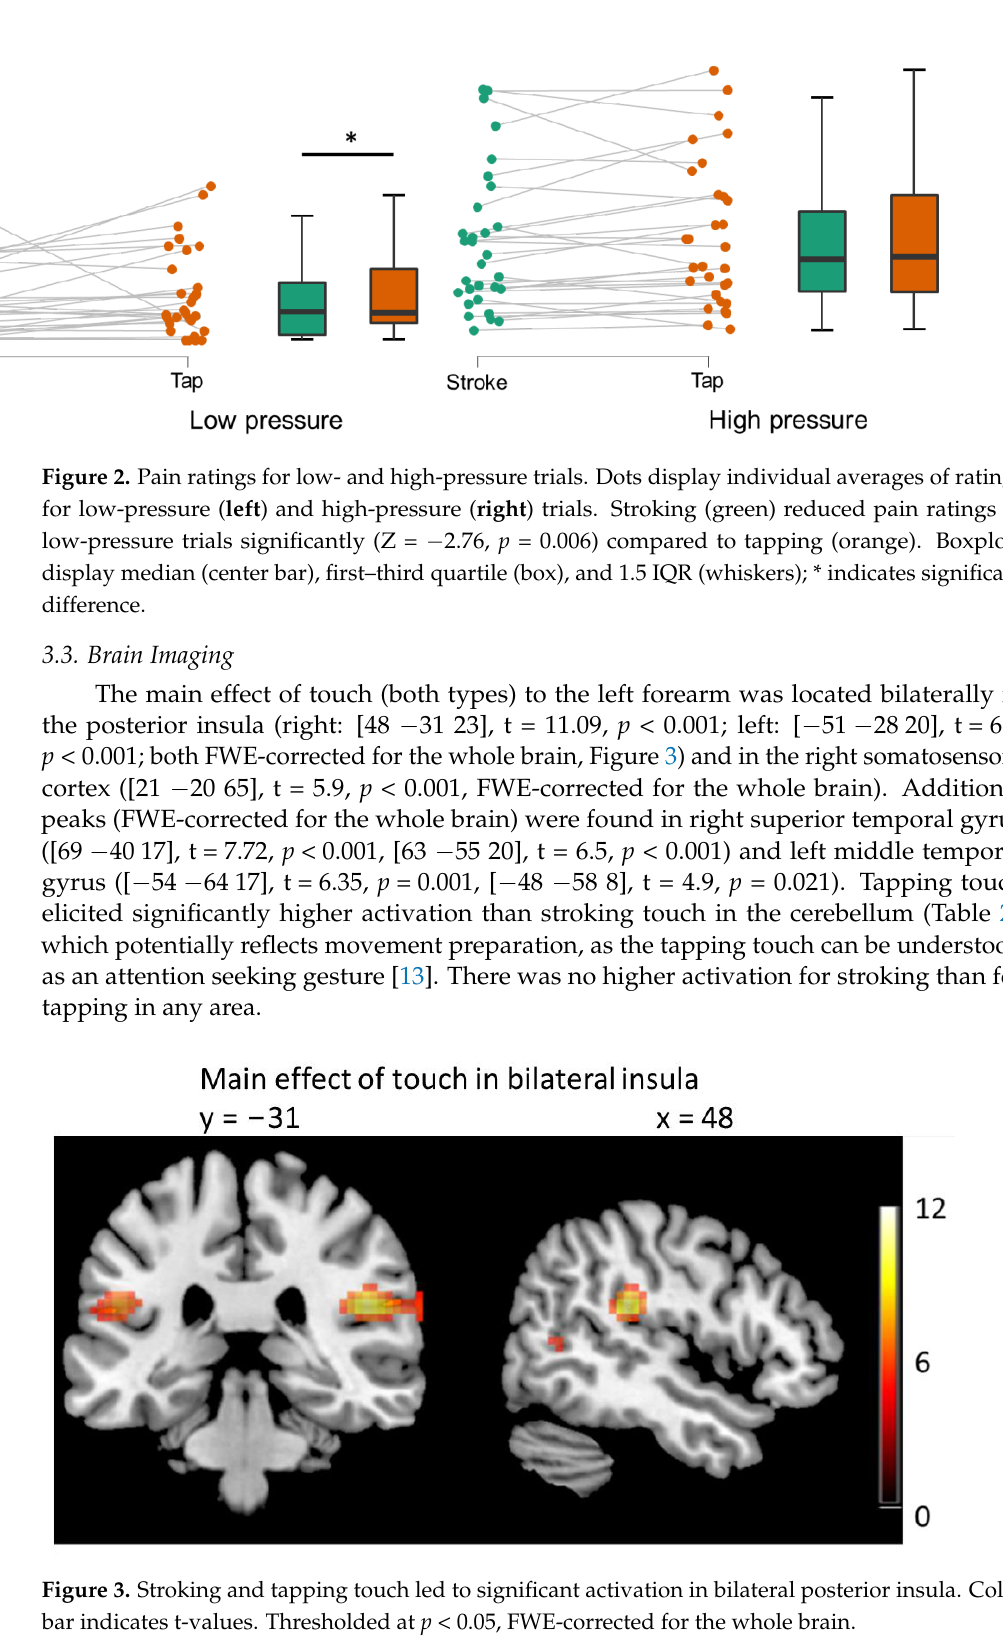
Table 3. Main effect of low and high pressure combined. R = right, L = left, FWE-corr = family- wise-error-corrected. Area